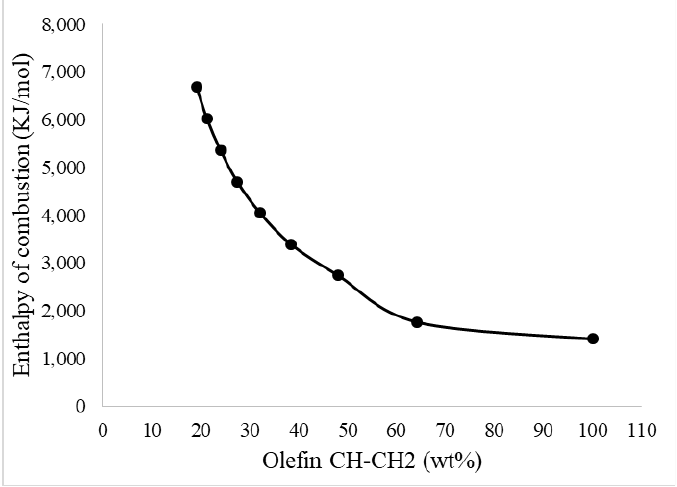
Figure 6. The effect of weight percentage of CH-CH2 on enthalpy of combustion for olefins .